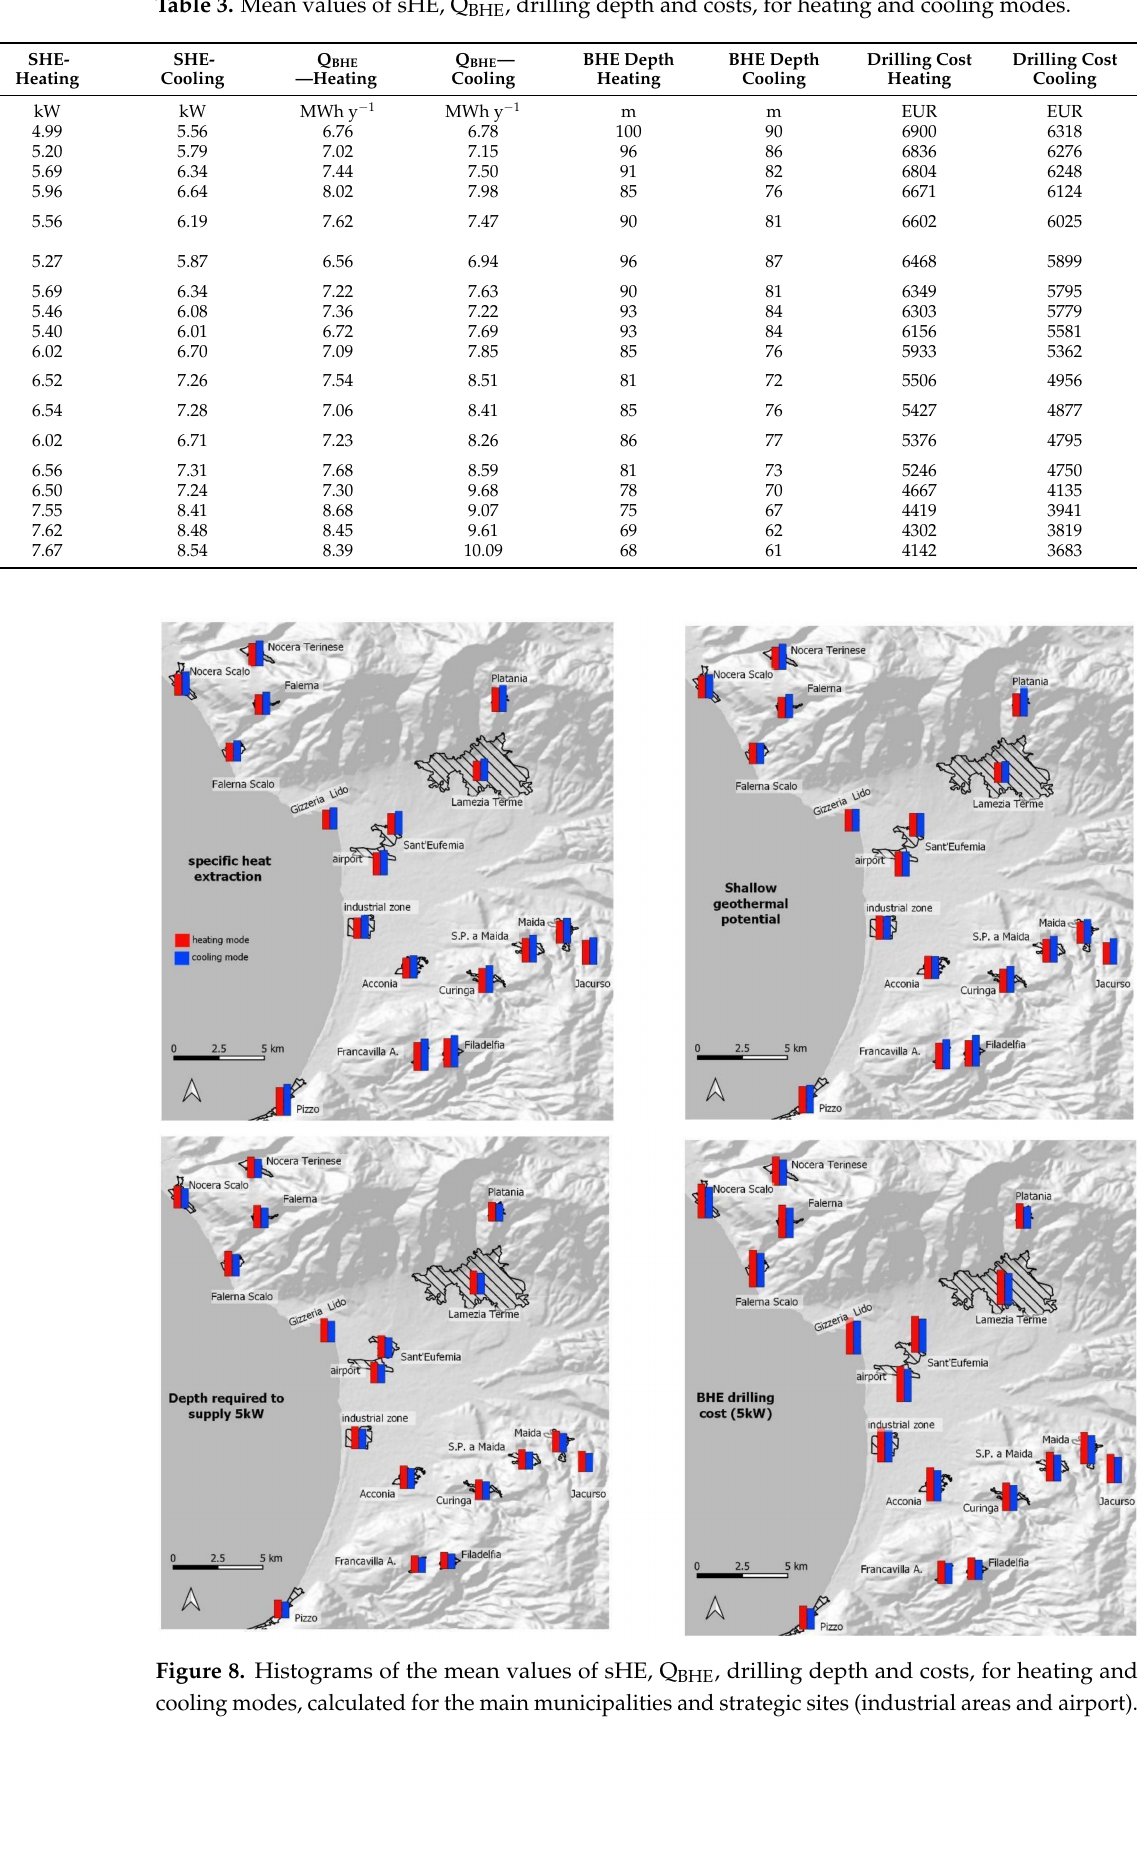
Table 3. Mean values of sHE, Q BHE , drilling depth and costs, for heating and cooling modes.